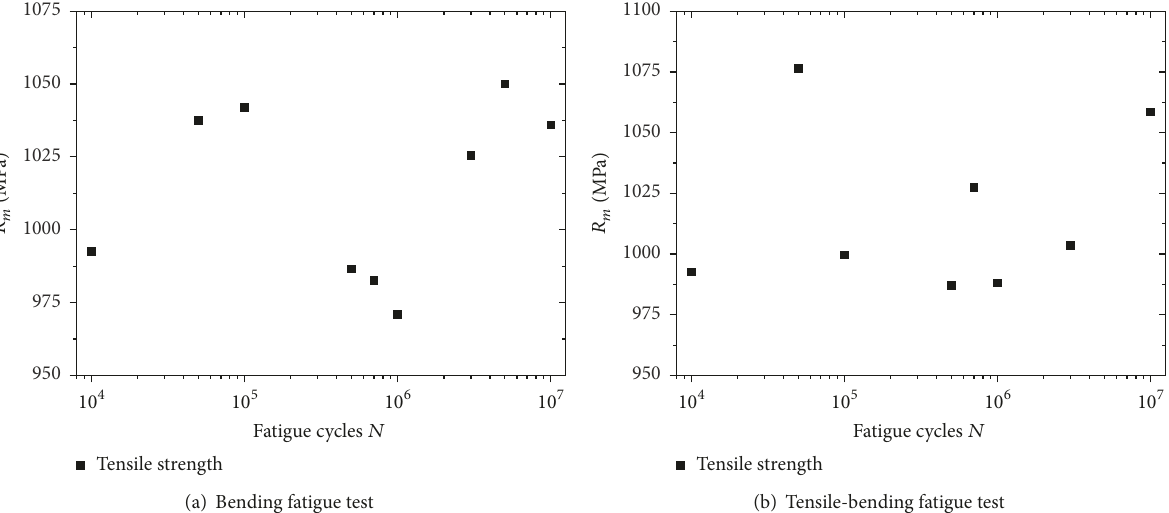
Figure 15: Tensile strength of two groups of specimens.